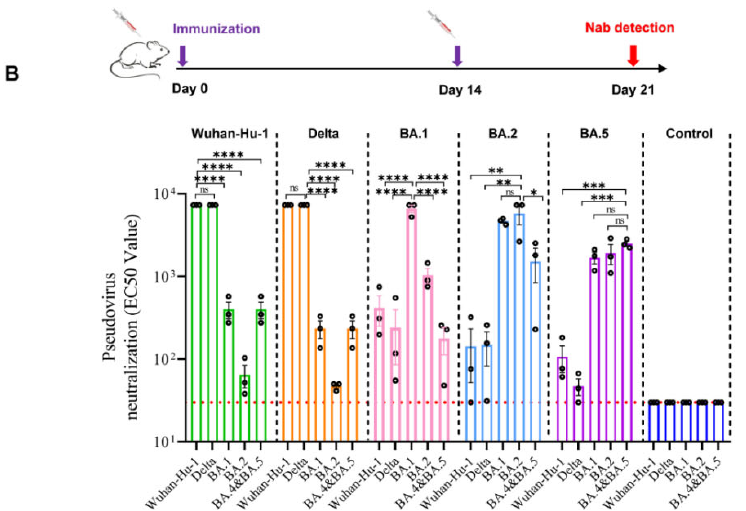
Figure 3. Profile of neutralizing antibodies produced by monovalent mRNA vaccines against SARS-CoV-2 variants in mice and Cynomolgus monkeys. ( A ) Cynomolgus monkeys were immunized twice with monovalent vaccines against Wuhan-Hu-1 strain, Delta strain or PBS on days 0 and 21. The VNTs were measured using a pseudovirus neutralization assay 35 days after the first immunization; n = 10. * p < 0.05; **** p < 0.0001; ns, no significance. ( B ) BALB/c mice were immunized twice with monovalent vaccines against Wuhan-Hu-1, Delta, Omicron BA.1, BA.2, BA.5 strain or PBS on days 0 and 14. The VNTs were measured using a pseudovirus neutralization assay 21 days after the first immunization; n = 3. * p < 0.05; ** p < 0.01; *** p < 0.001; **** p < 0.0001; ns, no